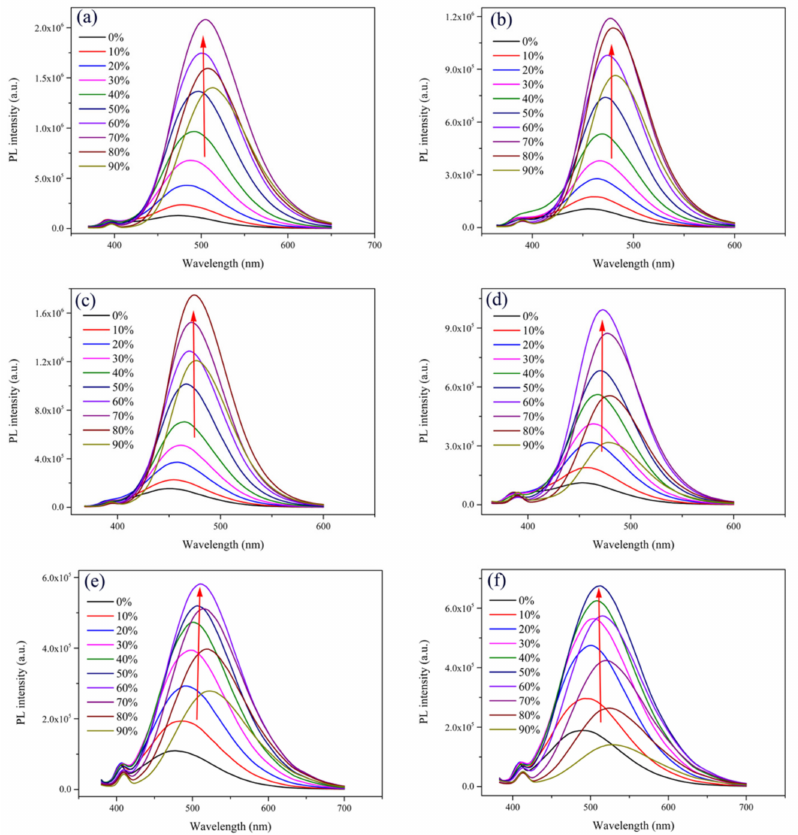
Figure 2. PL spectra of compounds ( a ) 1 , ( b ) 2 , ( c ) 3 , ( d ) 4 , ( e ) 5 , ( f ) 6 in CH 3 OH/H 2 O mixed solutions (c = 2.07 × 10 − 5 M) with different water fractions